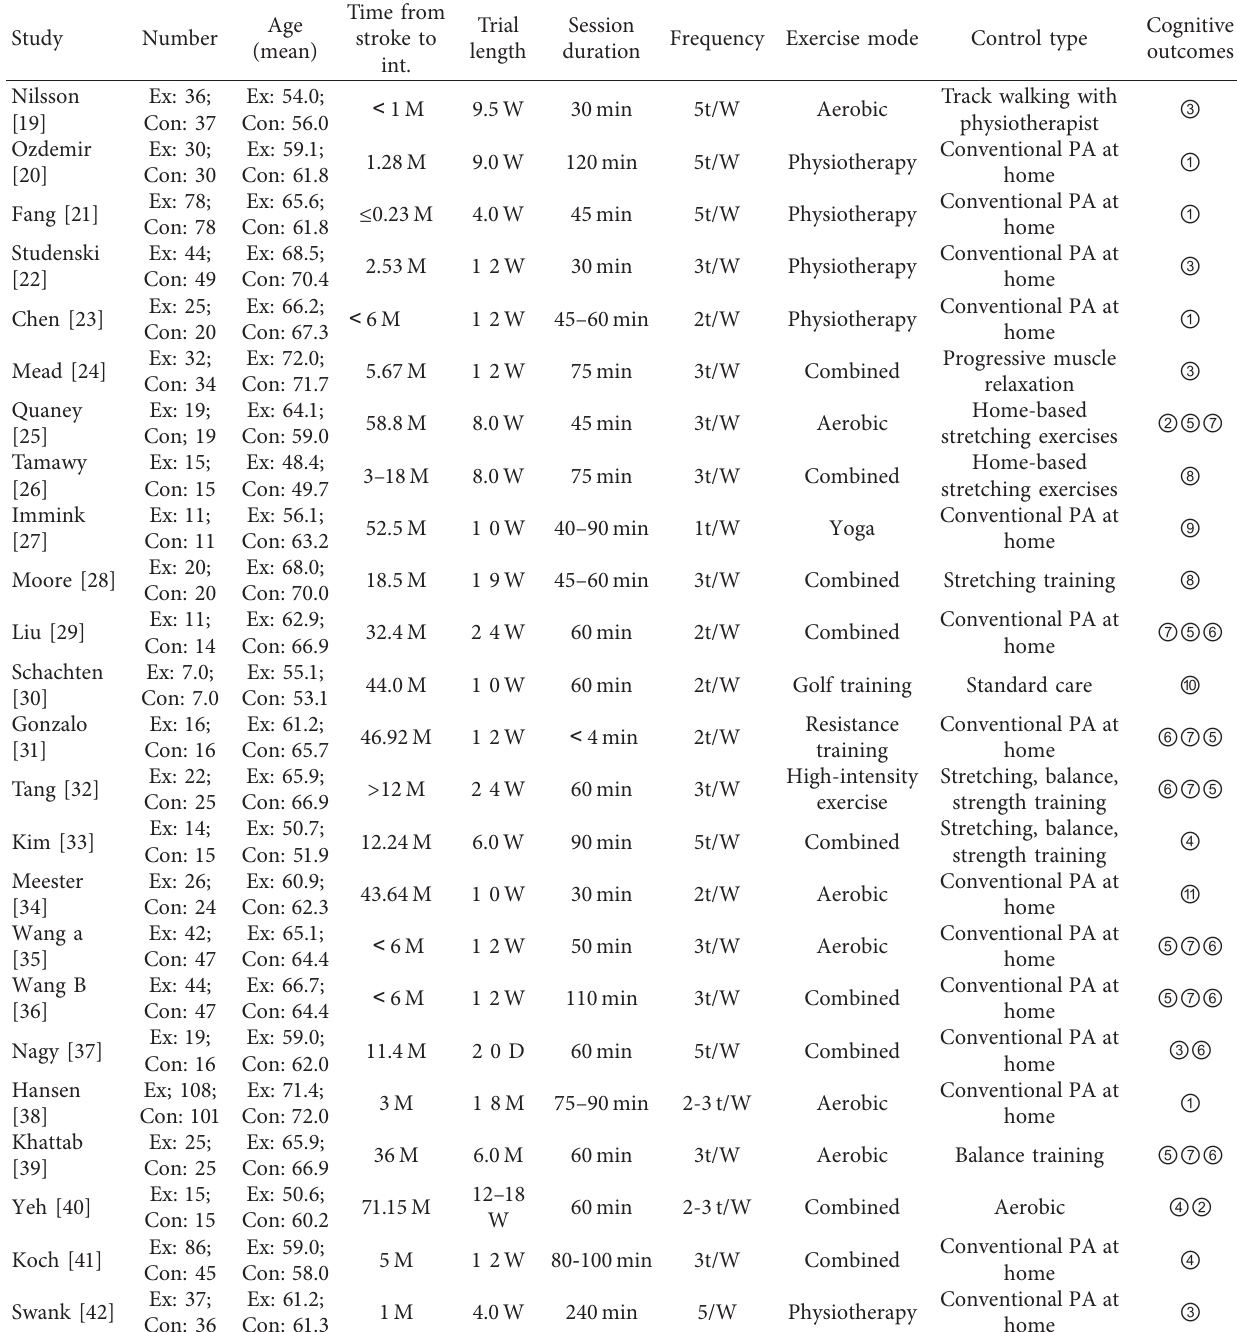
Table 1: Characteristics of the included